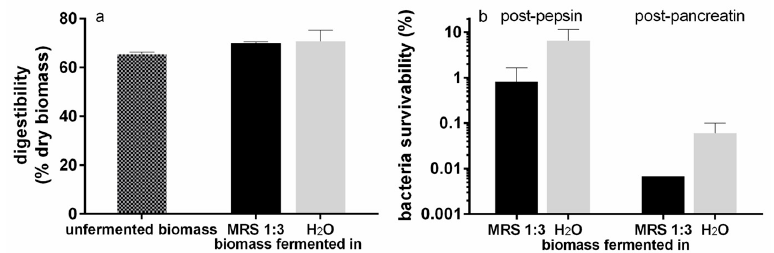
Figure 7. Digestibility of microalgal raw biomass and bacterial survivability. ( a ) Comparison between T. lutea F&M-M36 digestibility (% dry biomass) of unfermented biomass and biomass fermented with L. plantarum ATCC 8014 suspended in MRS 1:3 or H ₂ O. ( b ) Survivability of L. plantarum ATCC 8014 within the fermented substrate after in vitro digestion. Data are expressed as mean ± standard error; statistical significance set at p < 0.05.